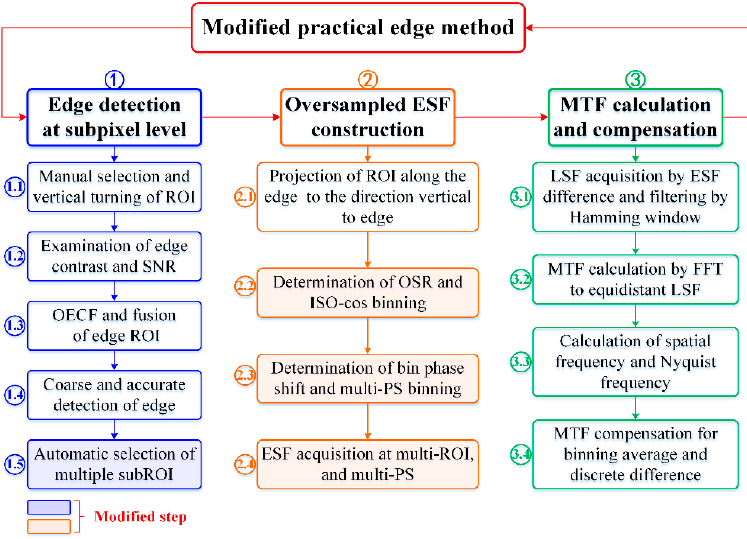
Figure 16. The processing steps of modified practical edge method.